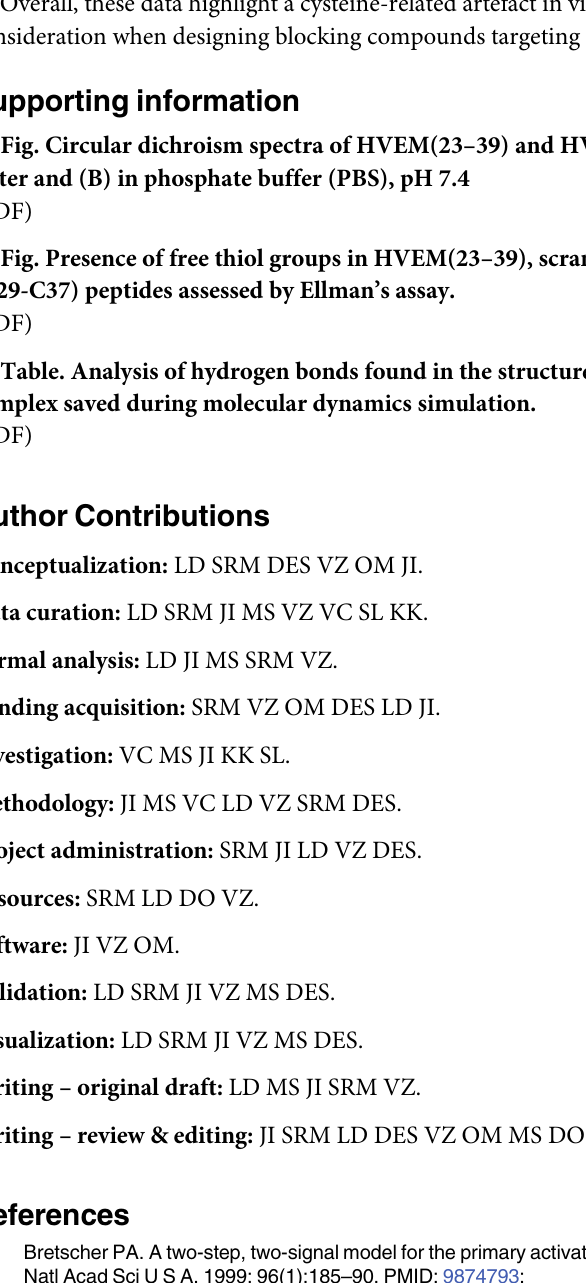
S1 Fig. Circular dichroism spectra of HVEM(23–39) and HVEM(23–39) (C29-C37) (A) in water and (B) in phosphate buffer (PBS), pH 7.4 S2 Fig. Presence of free thiol groups in HVEM(23–39), scrambled and HVEM(23–39) (C29-C37) peptides assessed by Ellman’s assay. S1 Table. Analysis of hydrogen bonds found in the structures of HVEM(23–39)-BTLA complex saved during molecular dynamics